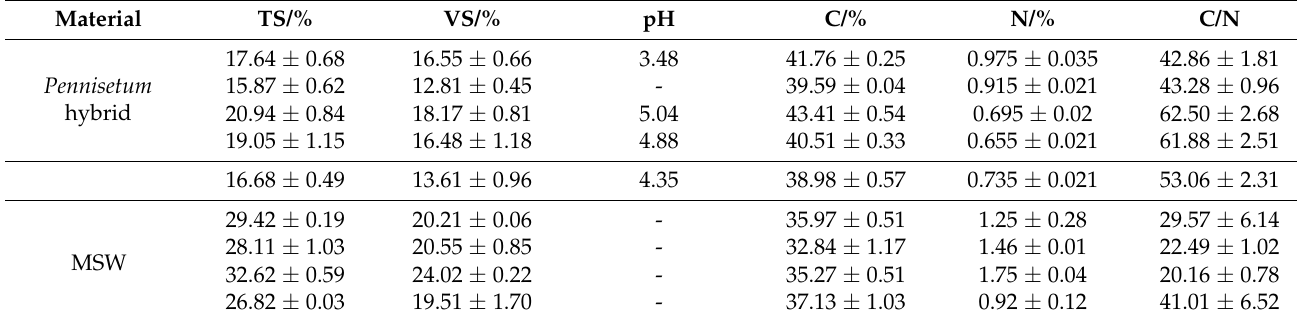
Table 1. Characteristics of Pennisetum hybrid and